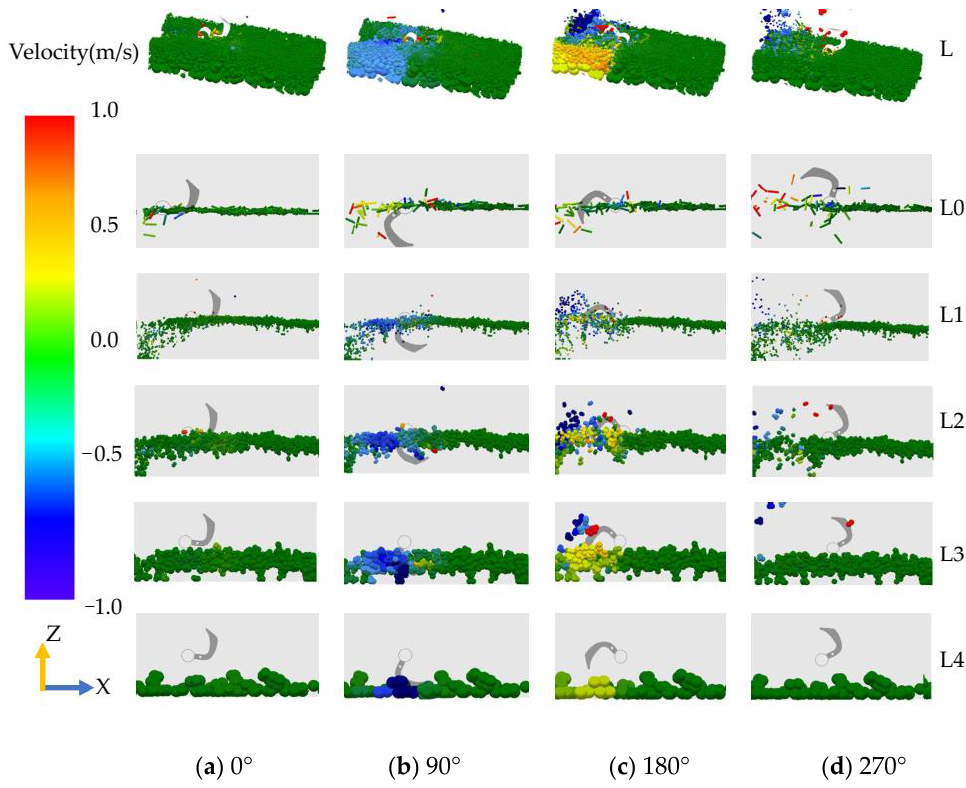
Figure 7. Velocity of soil and straw in different tillage layers during single blade operation.